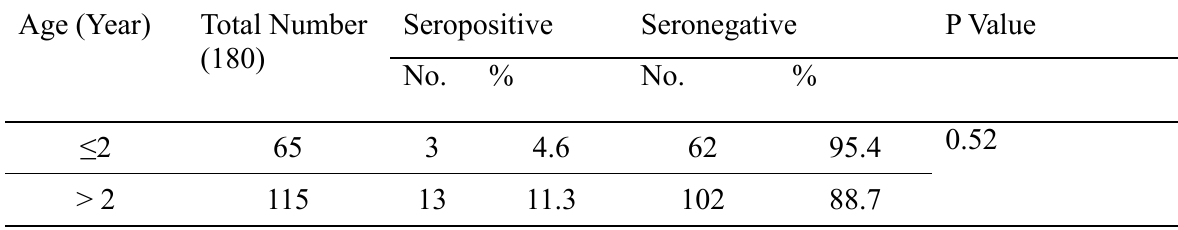
Table 5. The Seropositivity of Anti F. hepatica IgG antibodies in Sera of Sheep by ELISA according to the age